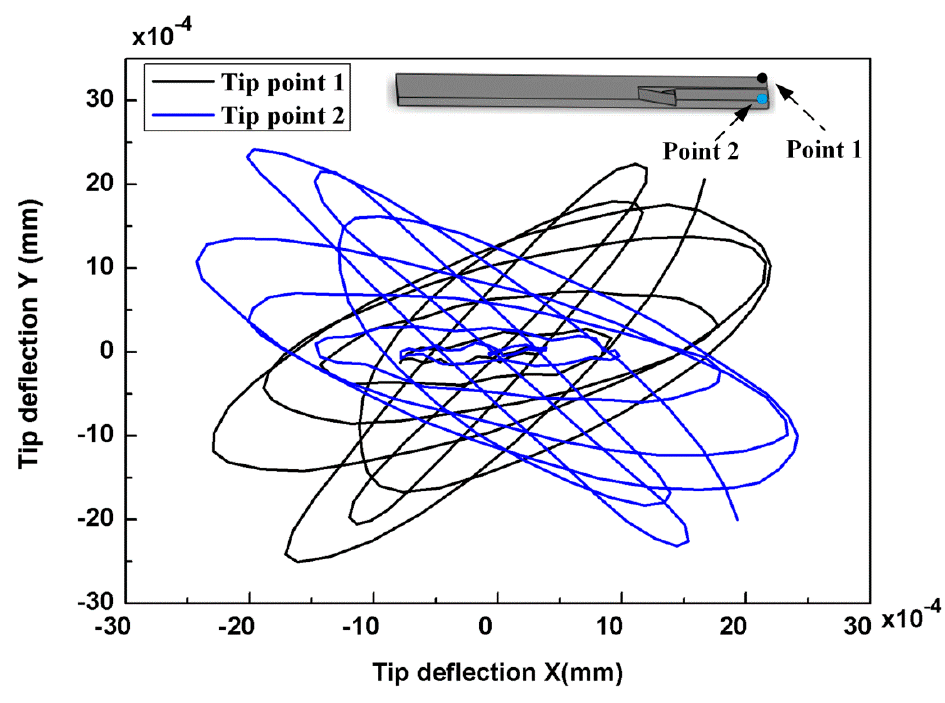
Appl. Sci. 2019 , 9 , x FOR PEER REVIEW Figure 6. The vibration trajectories of an actuator with a beam tip of 7 mm. Figure 6. The vibration trajectories of an actuator with a beam tip of 7 mm.